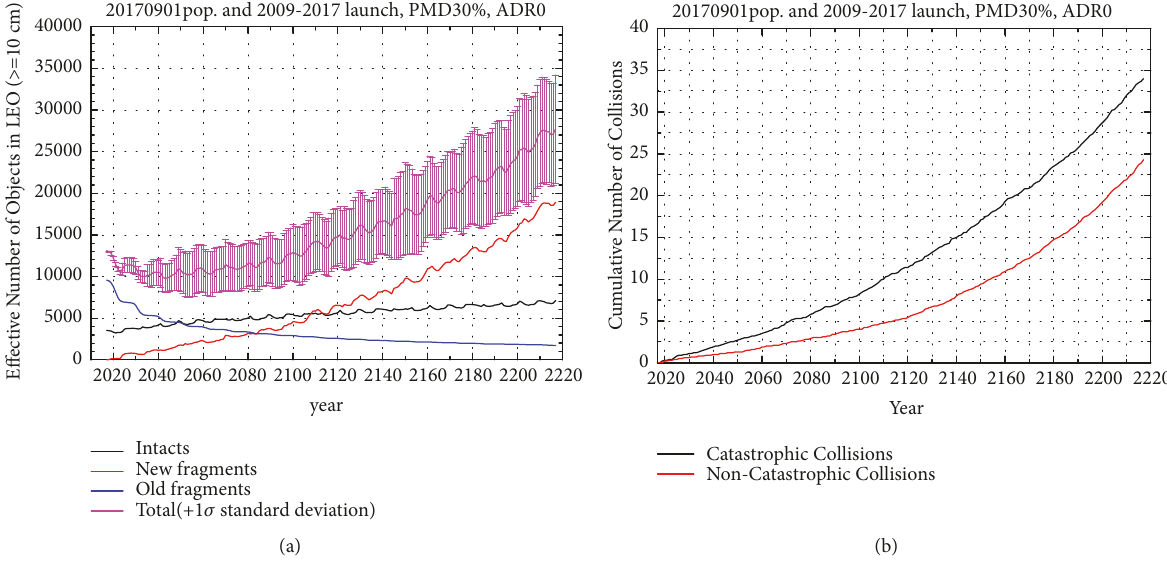
Figure 10: The evolution results of scenario 1, with PMD rate of 30%. (a) The population evolution. The line of total is plotted with the error bar of 1 𝜎 standard deviation. (b) The cumulative number of